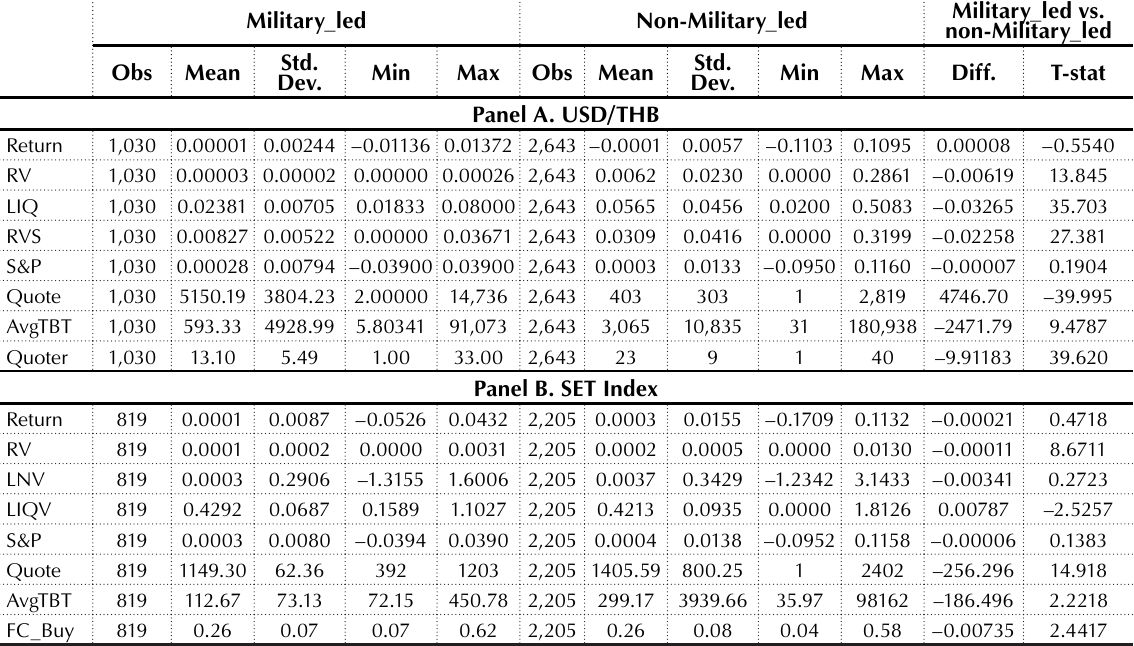
Table 2. Summary